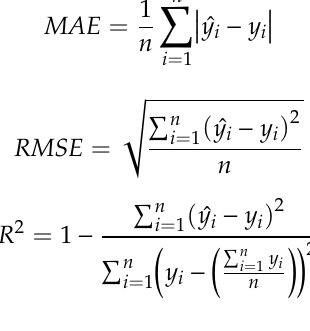
Figure 3. Three subsets of CBECS (group 1–3) used for experimenting impact of number, type, and combination of predictors on prediction error. m is the number of predictors in each group. Types of predictors that were added to each group are shown. Note: Bldg = building and BMS = building management system.